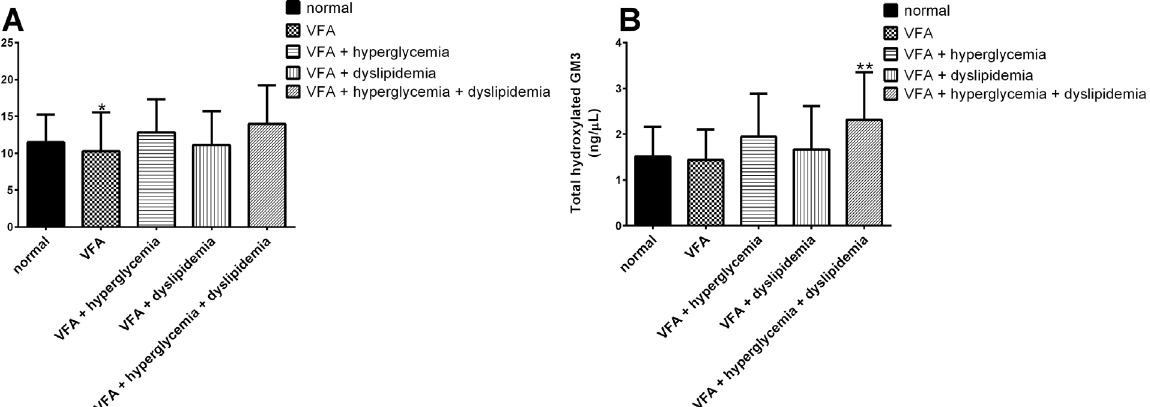
Fig 2. The sum of GM3 molecular species. Total GM3 (A) and total hydroxylated GM3 (B) detected in serum of patients with visceral fat accumulation (VFA) (n = 39), VFA with hyperglycemia (n = 15), VFA with dyslipidemia (n = 28) and VFA with both hyperglycemia and dyslipidemia (n = 17) compared with healthy lean control individuals (n = 26). Species were determined using LC-MS/MS MRM. Data are reported as means ± SD. * P (cid:3) 0.05, ** P (cid:3) 0.01, *** P (cid:3) 0.001, **** P (cid:3) 0.0001 metabolic risk factor groups vs. control; Mann-Whitney unpaired